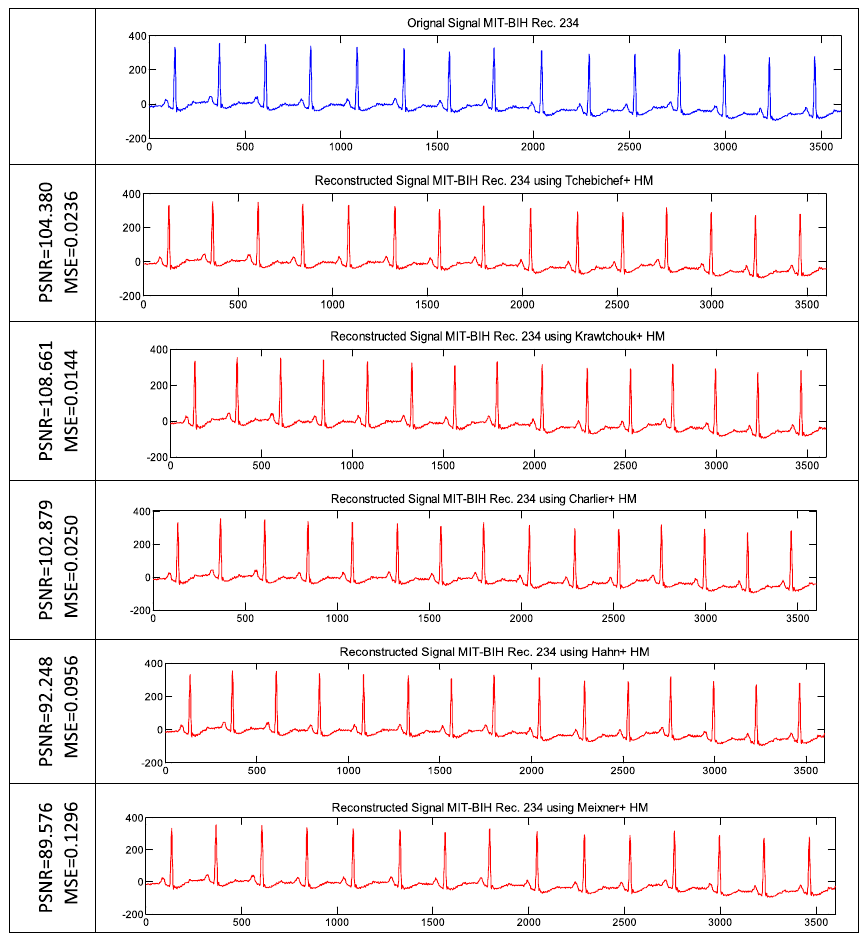
Fig. 8 Set of reconstructed “Rec. 234” signal using Tchebichef, Krawtchouk , Charlier, Hahn, and Meixner moment with Householder